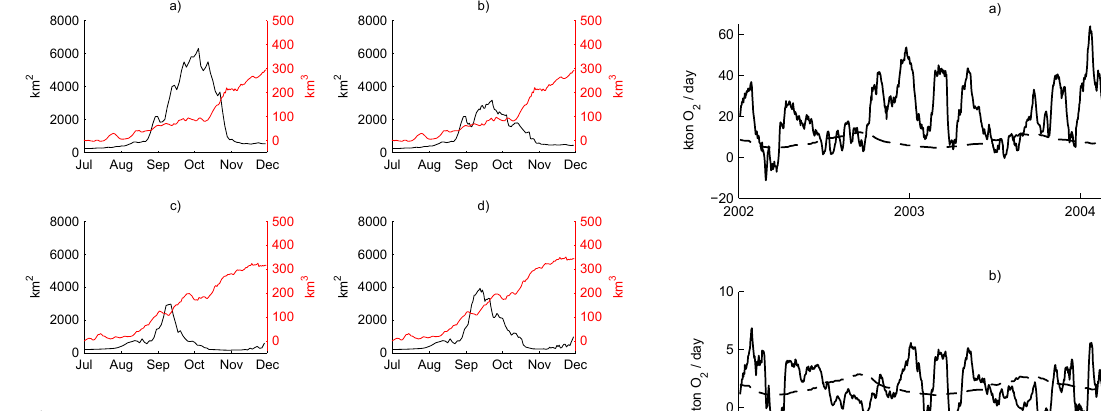
Fig. 11. The black line indicates time evaluation of hypoxic area in the domain (Arkona basin excluded) and the red line shows the integrated southward transport below 15m across section S1 from 1 July to 30 November for (a) 2002, (b) 2002 with increased Septem- ber wind, (c) 2004 and (d) 2004 with decreased September wind. Fig. 12. Comparison between the advective DO input (solid line) and the respiratory sink (dotted line) for the bottom water of (a) Eastern Kattegat and (b) the Belt Seas. The DO flux is calculated by using the transport across S1 and S2 for Kattegat and Great Belt, respectively, and is smoothed with a one month running